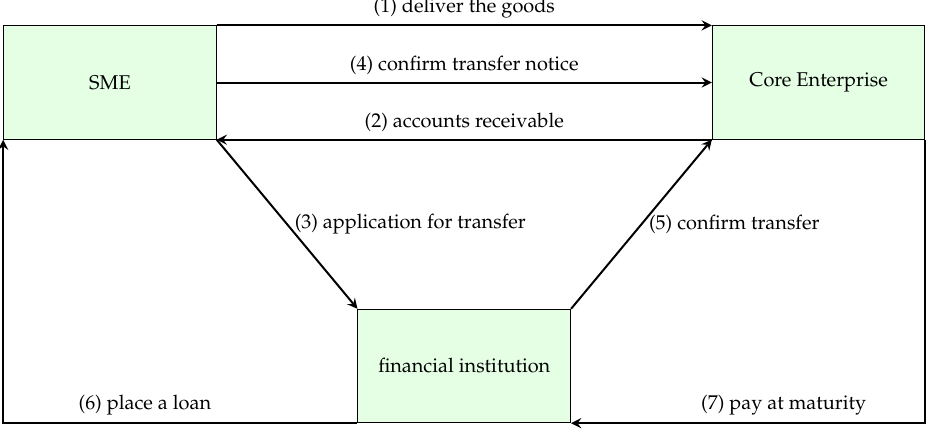
Figure 1. The process of accounts receivable factoring